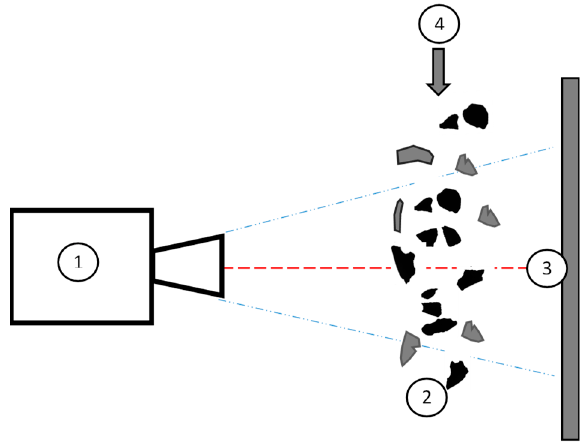
Figure 2. The scheme of dynamic image analysis (DIA) measurement system: 1—camera, 2—measurement volume, 3—light source, 4—feeding direction of particles.